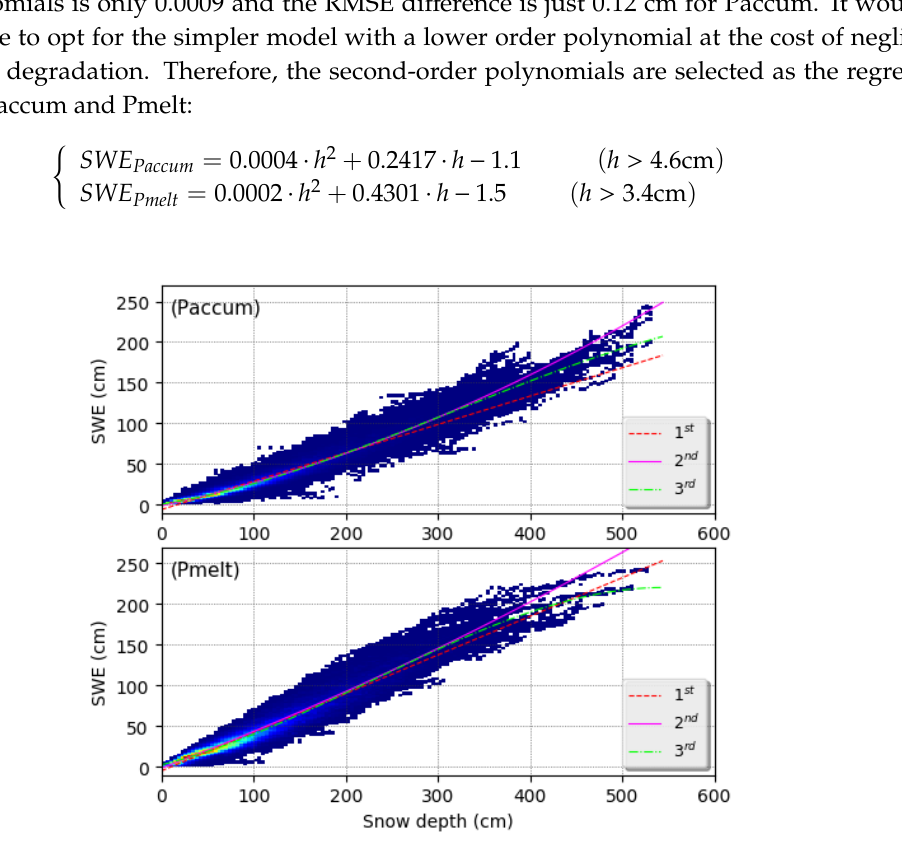
Figure 5. Scatterplot of SWE versus the snow depth and the polynomial fitting results in Paccum (upper) and Pmelt (lower). Table 2. Fitting polynomial coefficients and correlation coefficients for Paccum and Pmelt. Phase